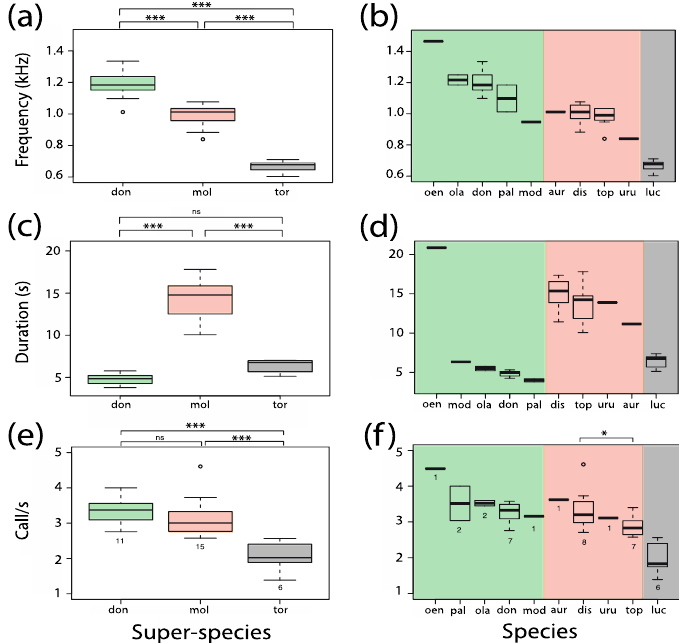
Figure 11. Variation in three acoustic parameters of the titis vocal duets is shown for the three lineages